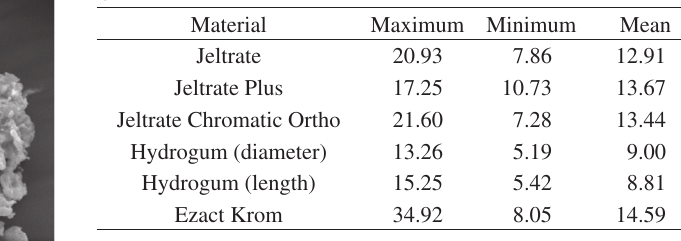
Table 3. Maximum, minimum, and mean values for alginate filler size ( µ